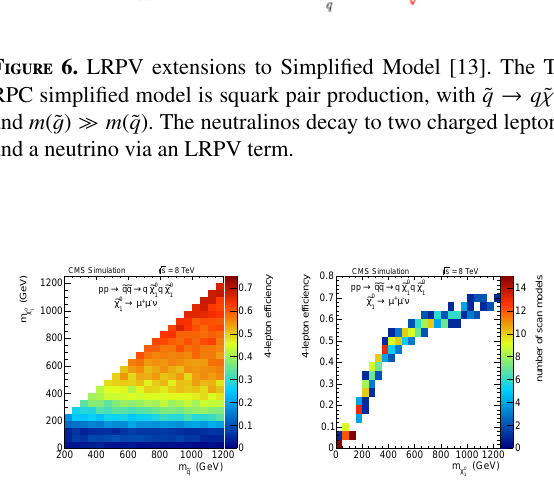
Table 4. Observed events and expected background contributions. M 1 and M 2 intervals are in GeV.